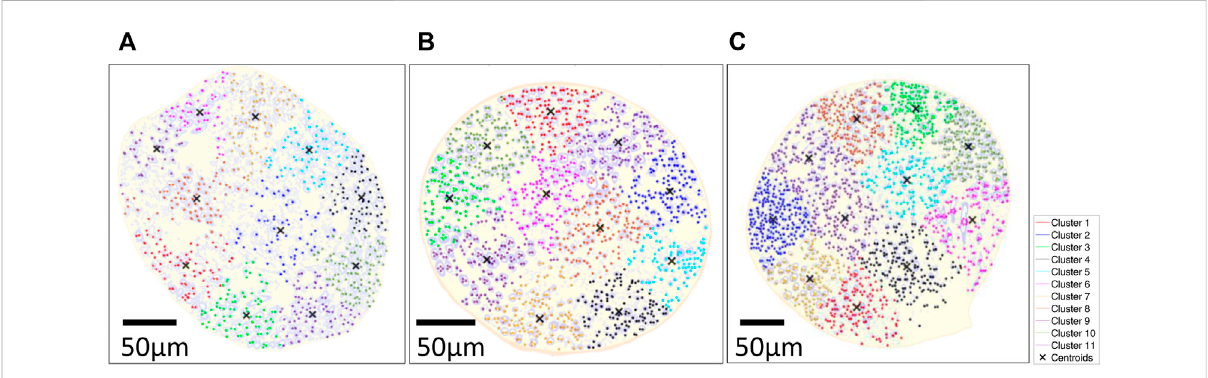
FIGURE 11 k-means clustered on large fi ber group in large fi ber group overlaid on the segmented results of three rats; (A) Rat A; (B) Rat B; (C) Rat (C) k-means clustering algorithm was used with distance measure using the sum of absolute differences (i.e., citiblock) as a cost function with the fi ve repetitions with 11 clusters displayed in different colormap and ’ X ’ as centroids of each cluster. The fi ber diameter was used for weight on k-means cluster (i.e., w = 1: 3 – 5 µm, w = 2: 6 – 9 µm, w = 3: 9 – 12 µm, w = 4: 12 – 15 µm, w = 5: > 15 µm).